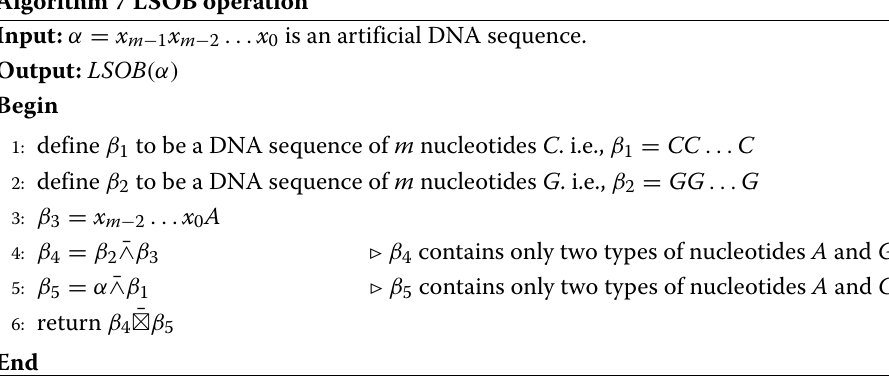
Algorithm 7 LSOB